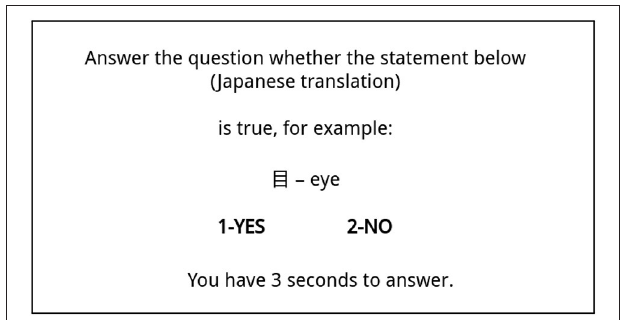
FIGURE 1 | Typical screen shown to participant during the experiment. In this case participant was to decide whether this Kanji sign means Eye, having perfect knowledge about it.